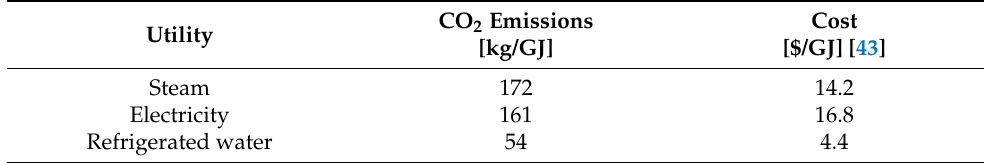
Table 4. CO 2 -emission factors and utility